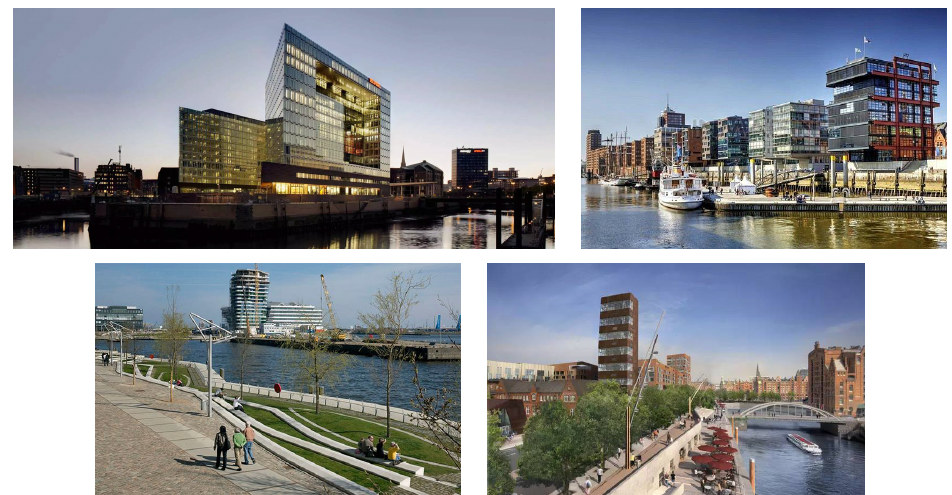
Fig. 4 Hafencity waterfront urban landscape ( Source : Internet)